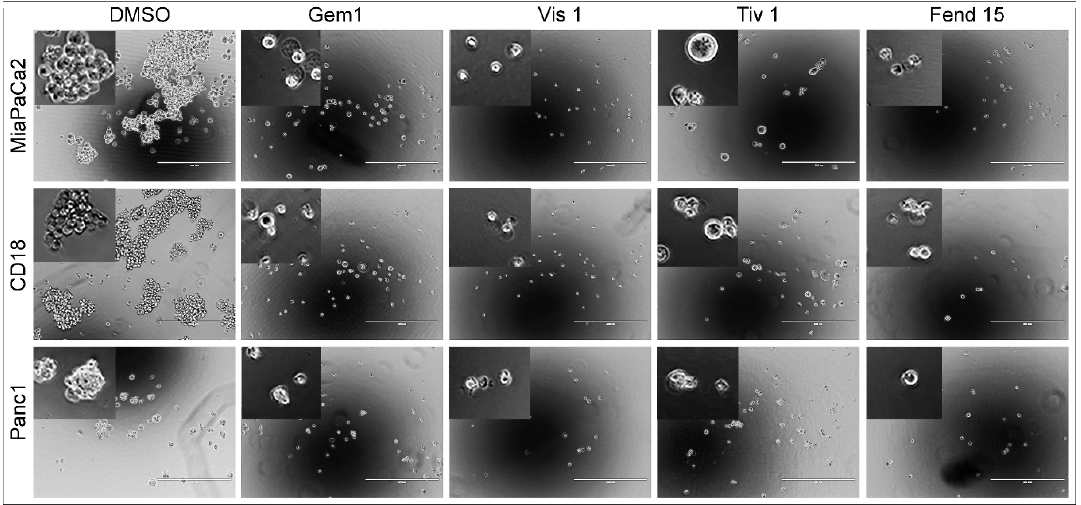
Figure 5. PDAC cells treated with fendiline, gemcitabine, visudyne or tivantinib show reduced sphere formation: MiaPaCa2, CD18 or Panc1 cells were plated with or without 1 μ M Gemcitabine formation: MiaPaCa2, CD18 or Panc1 cells were plated with or without 1 µ M Gemcitabine (Gem1), (Gem1), 1 µM visudyne (Vis 1), 1 µM tivantinib (Tiv 1) or 15 µM fendiline (Fend 15) alone or in 1 µ M visudyne (Vis 1), 1 µ M tivantinib (Tiv 1) or 15 µ M fendiline (Fend 15) alone or in combination (combination is not shown as the self renewal was completely inhibited by the treatment).